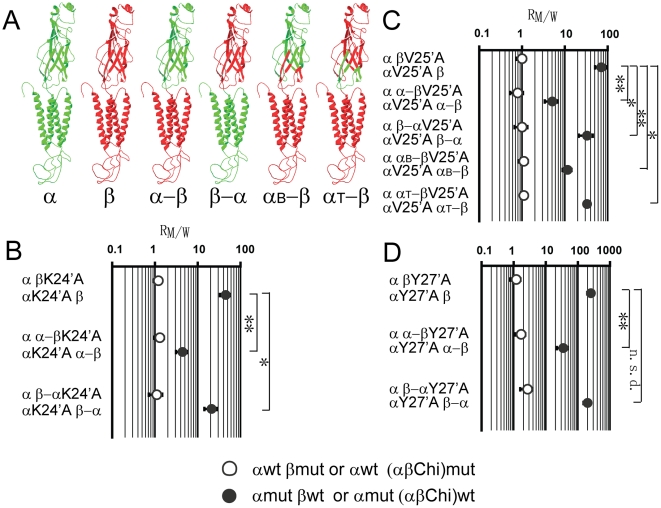
Effects of M2–M3 loop mutations on chimeric α1 β GlyR channel function.(A) The molecular identity of each chimera is schematically illustrated, with green and red denoting α1 and β subunit sequences, respectively. (B–D) The RM/Ws (the EC50 of the mutant chimeric α1 β GlyR divided by the EC50 of its relevant WT chimeric α1 β GlyR) resulting from introducing the K24′A, V25′A or Y27′A mutation. The symbol (○) represents constructs containing WT α1 and mutant β or other indicated chimeric subunit, while the symbol (•) represents constructs containing mutant α1 and WT β or other indicated chimeric subunit. (* p<0.05; ** p<0.01; n.s.d. not significantly different; using the Student's t-test).